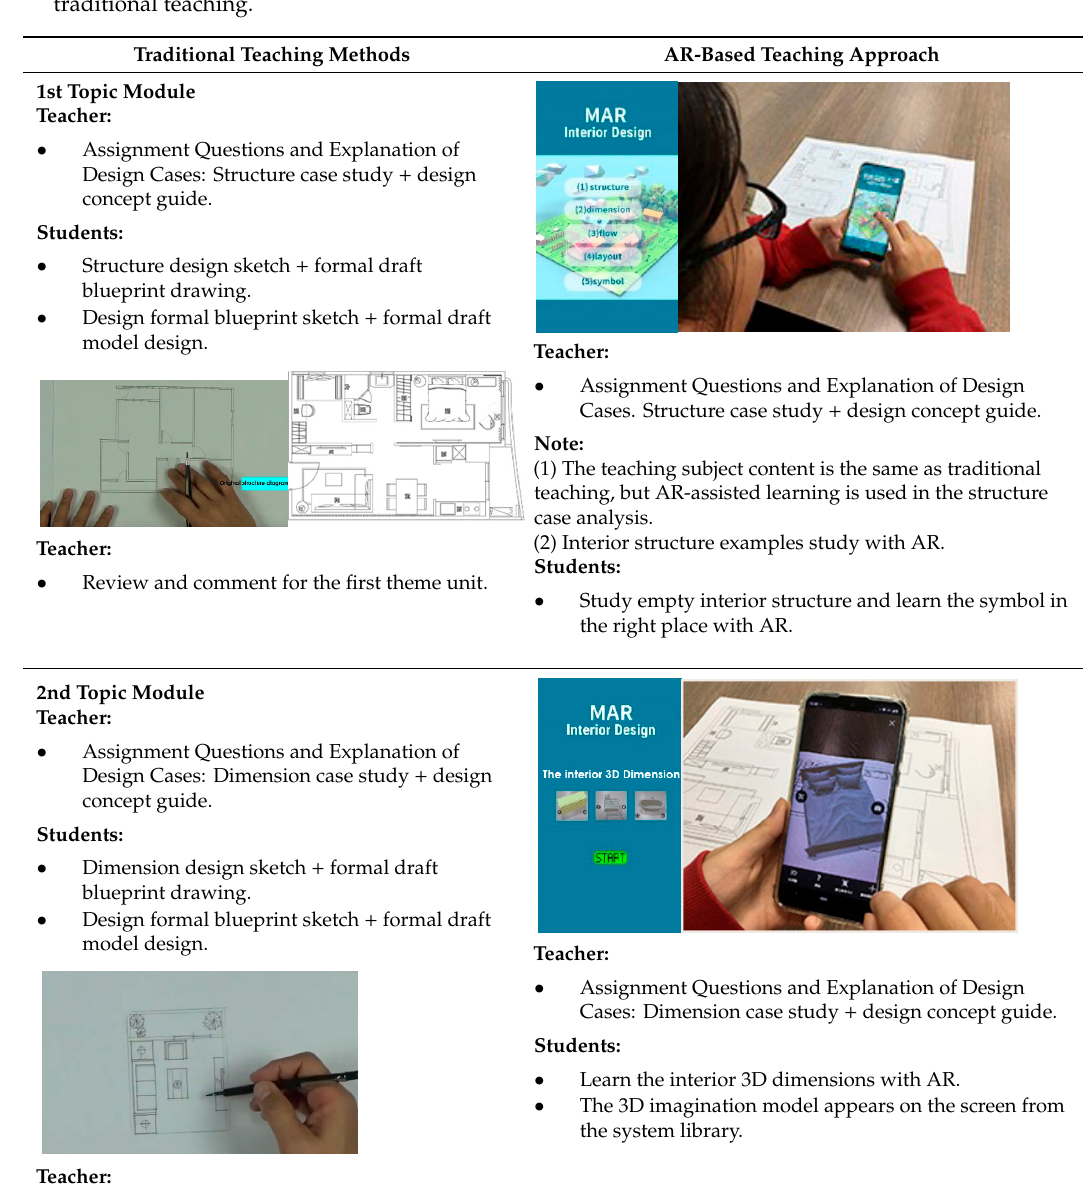
Table 2. Software run-through and comparison between experimental AR-based and